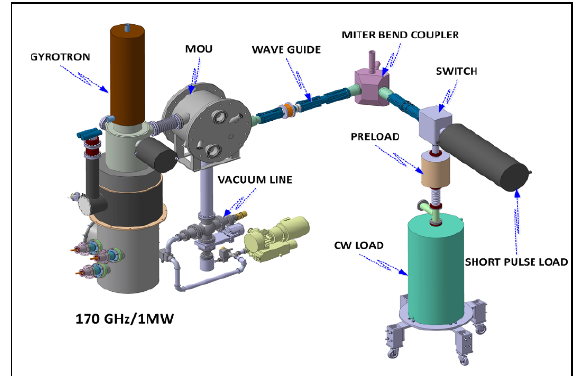
Fig. 2 : Schematic of Test Gyrotron & waveguide set test configuration